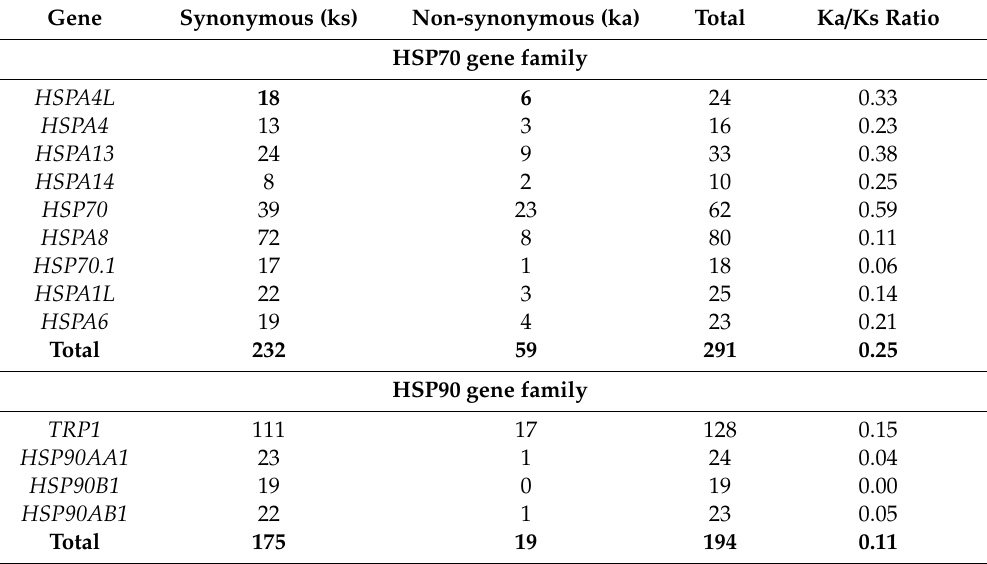
Table 6. SNPs in coding region of HSP 70 and HSP90 gene family in bu ff